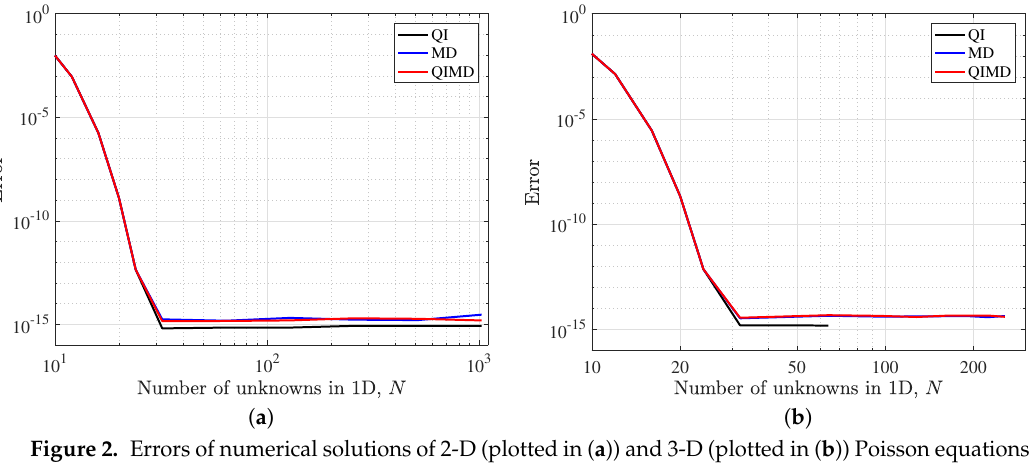
Figure 2. Errors of numerical solutions of 2-D (plotted in ( a )) and 3-D (plotted in ( b )) Poisson equations with a the high number of N . In both 2-D and 3-D problems, the errors of the proposed method (QIMD) do not rise as N increases. The proposed method shows the same order of accuracy as the quasi-inverse method and the matrix diagonalization method.